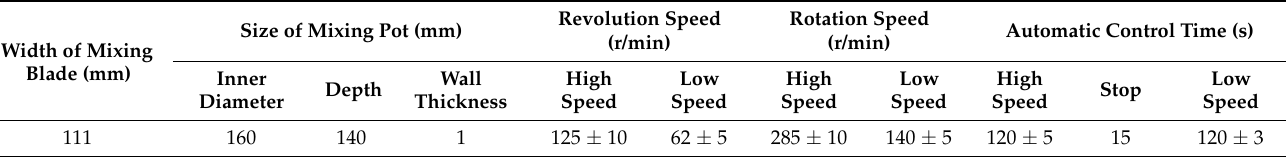
Figure 6. Testing of cement grout (( a ) The NJ-160A cement paste mixer, ( b ) The bleeding test and ( c ) The compressive strength test). Table 4. The mixing process and technical parameters of